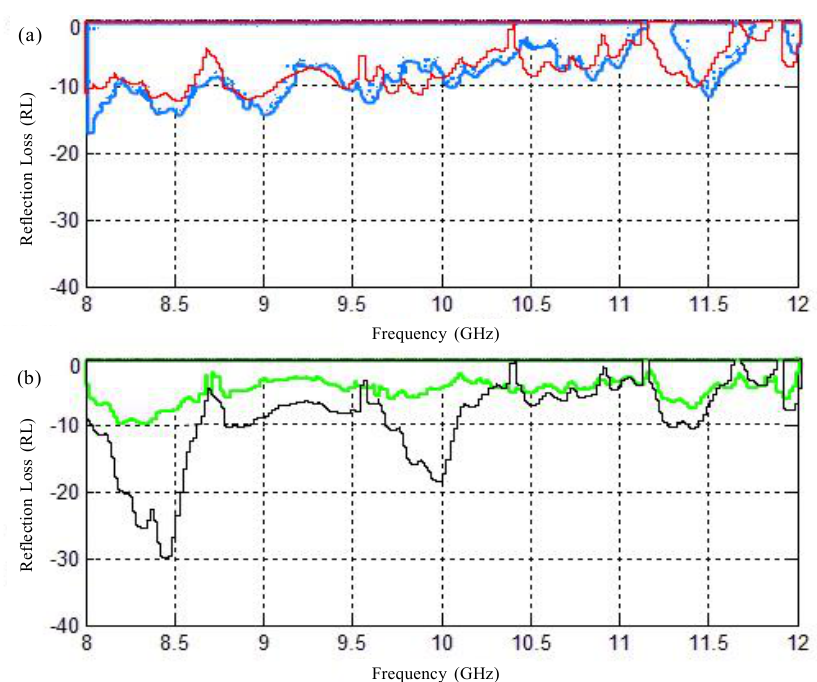
thicknesses.Fig. 7. The RL curves of: (a) A3 (red) and A5 (blue) and (b) A4 (black) and A6 (green)